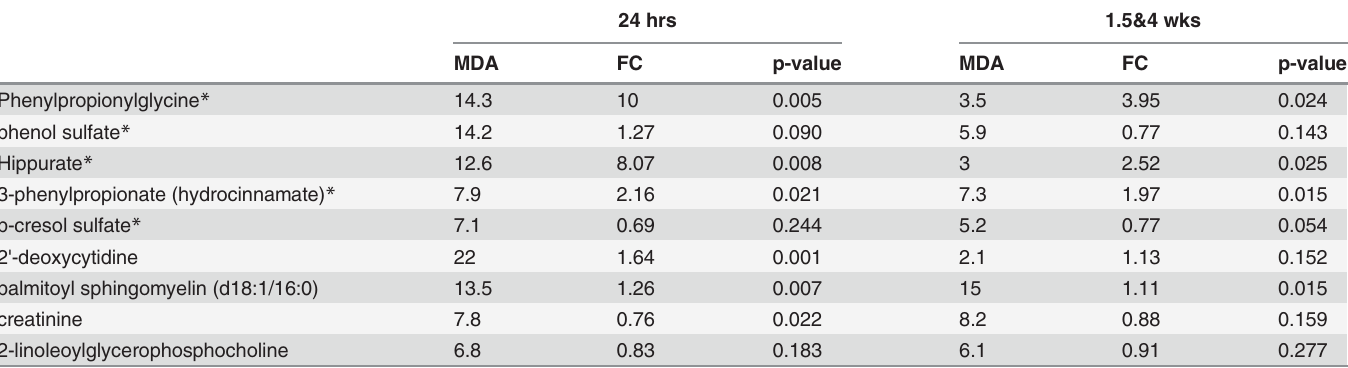
Table 2. Metabolites that classify AggE vs. Ctrl mice at both acute and chronic time